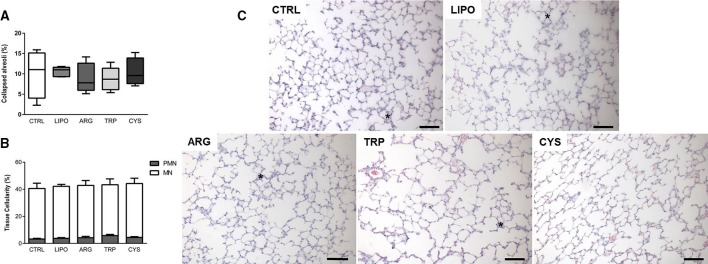
Effects of lipopolymers on lung inflammation. The control group (CTRL) was instilled with vehicle, the LIPO group was instilled with the lipopolymer only, and the ARG, TRP, and CYS groups were instilled with lipopolymer containing l-arginine, l-tryptophan, and l-cysteine, respectively. (A) Lung morphometry box plot (min. to max.). (B) Lung cellularity (PMN, polymorphonuclear cells; MN, mononuclear cells). Values are means ± SD of five animals in each group (data gathered from 10 random fields per animal). (C) Representative photomicrographs of lung parenchyma (×200, scale bar represents 100 μm). Asterisks indicate collapsed alveoli.